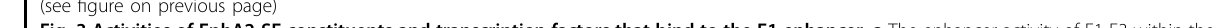
Fig. 3 Activities of EphA2-SE constituents and transcription factors that bind to the E1 enhancer. a The enhancer activity of E1-E3 within the EphA2-SE region was measured by dual-luciferase reporter assays in HeLa, HCT-116 and MCF-7 cells, respectively. b Top, transcription factor density. The abscissa represents the E1 component enhancer region, and the ordinate represents the number of transcription factors. Bottom, the enhancer activity of the two fragments of E1 was measured. c Veen displays transcription factors that bind to both the E1 component enhancer and the EphA2 core promoter region. d Correlation analysis of 31 transcription factors bound in the E1 enhancer and core promoter regions. We use the Cbioportal website (https://www.cbioportal.org/) to retrieve data from the cell lines (Broad 2019, Novartis/Broad Nature 2012 and NCI Cancer Res 2012) databases. e The expression of EphA2 was detected by qRT-PCR and western blotting after knocking down FOSL2 and TCF7L2. f ChIP-seq pro fi les of FOSL2 and TCF7L2 transcription factors in E1-E3 component enhancers. g The motifs of FOSL2 and TCF7L2. h E1 enhancer activity decreases after the binding sites of FOSL2 and TCF7L2 are deleted. i The E1 enhancer activity was reduced after adding siFOSL2 and siTCF7L2, respectively. j The expression of EphA2 after partial deletion of E1-E3 component enhancers. Error bars, mean ± SD. n = 3. p values were calculated using t -test. * p < 0.05, ** p < 0.01, *** p <